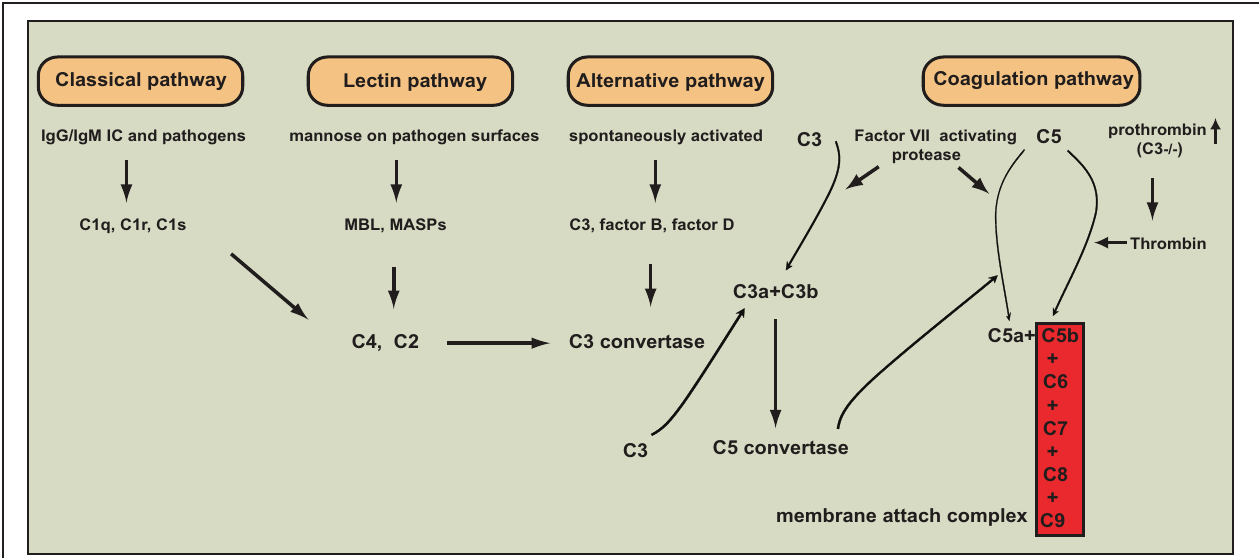
FIGURE 1 | The various pathways of complement activation. Four major pathways are involved in complement activation: classical, lectin, alternative, and coagulation pathways.